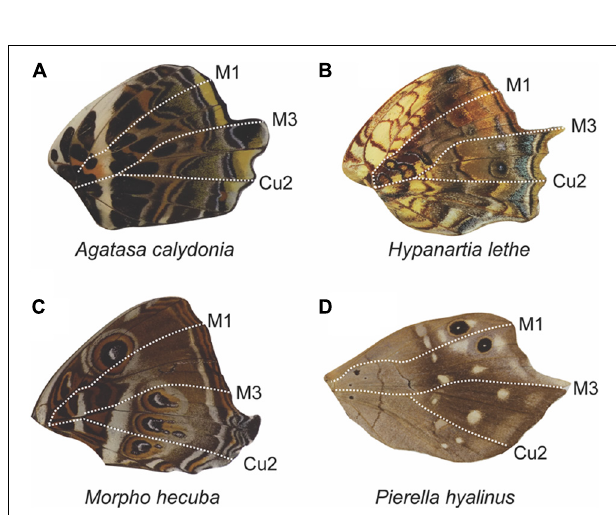
FIGURE 11 | Anterior–posterior dislocation at the M3 vein in hindwings. Butterfly wings can display elongation of the M3, Cu1, and Cu2 veins, leading to a larger posterior wing region (A–D) . In some cases, the region of elongation begins at the M3 vein (A,B) , in the intervein region posterior to M3 (C) , or in the intervein region anterior to M3 (D) , suggesting that the expression domain boundary can shift. All four wing examples are from the family